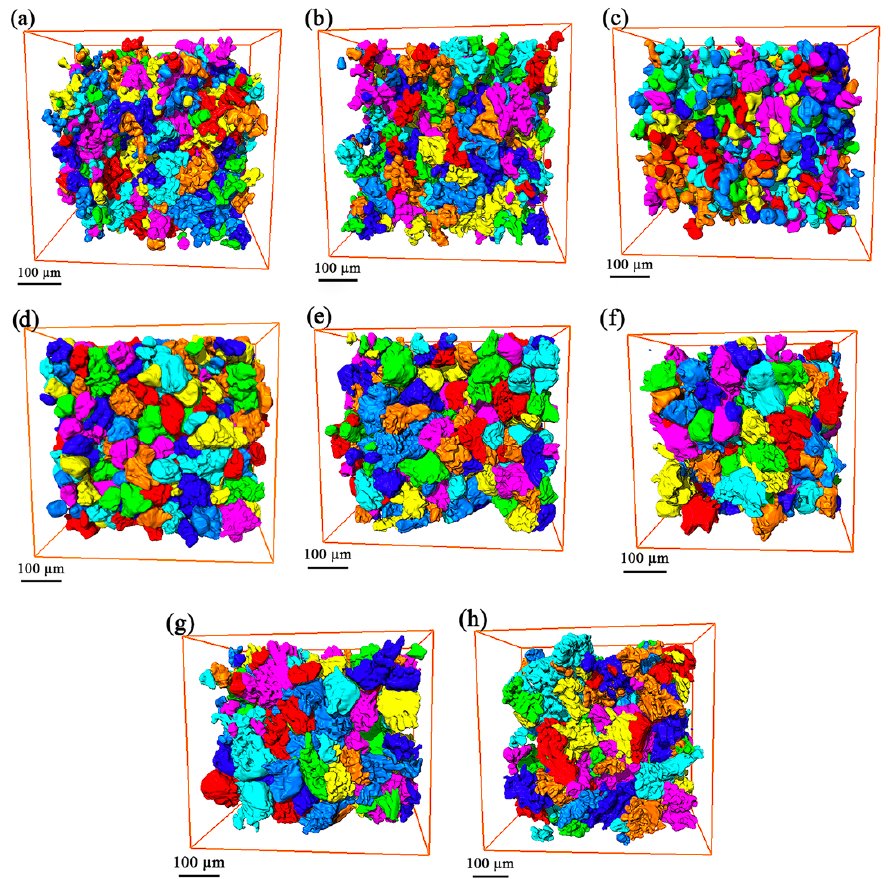
Figure 6. Three-dimensional rendering of Mg dendrites in Mg–10Zn–6.8Gd–4Y after an isothermal heat treatment at 580 °C for different holding times: ( a ) 0 min; ( b ) 2.5 min; ( c ) 5 min; ( d ) 10 min; ( e ) 15 min; ( f ) 30 min; ( g ) 60 min; ( h ) 120 min.